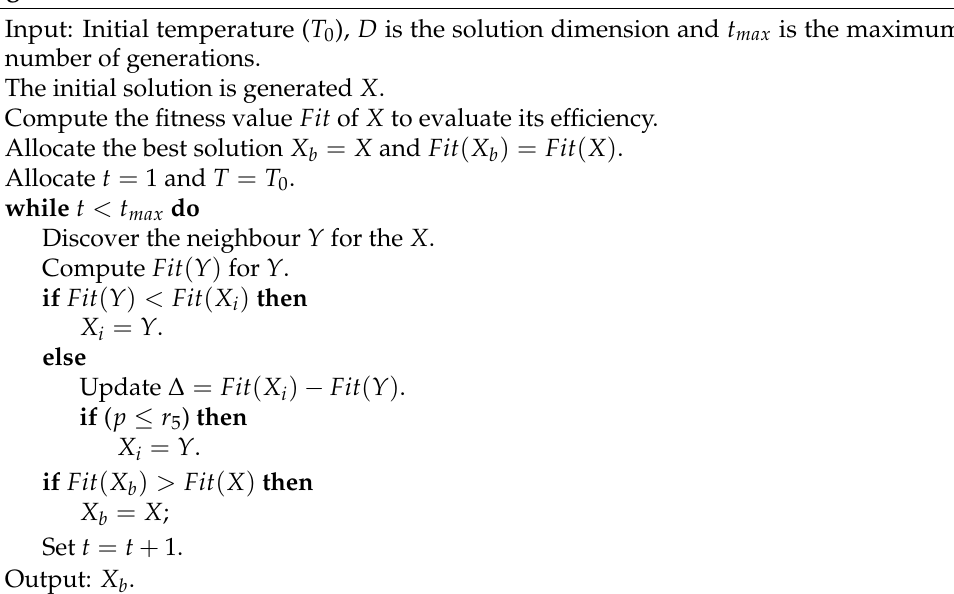
Algorithm 2 The SA